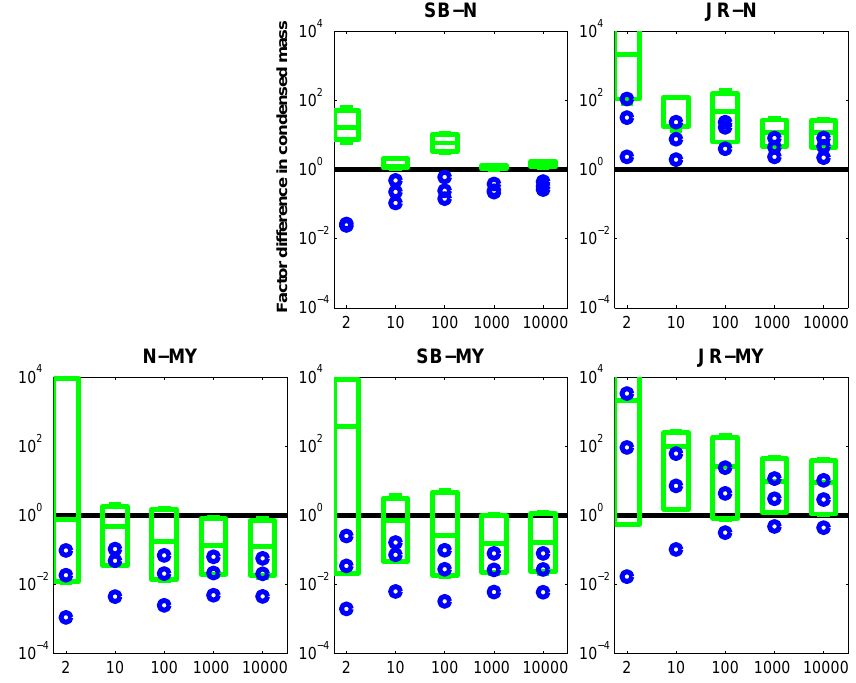
G.McFiggansetal.: SOAcomponentpartitioningsensitivity;part1